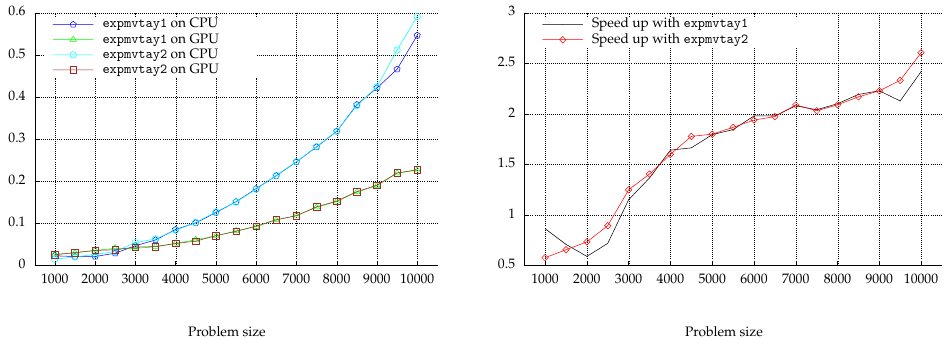
Figure 4. Comparison of time (seconds) and performance (speed up) of expmvtay1 and expmvtay2 being executed on both a CPU and a GPU